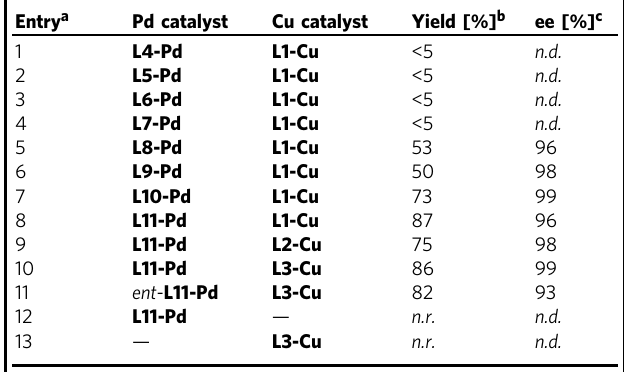
Table 1 Optimization of catalyst system for the cross- coupling reaction.